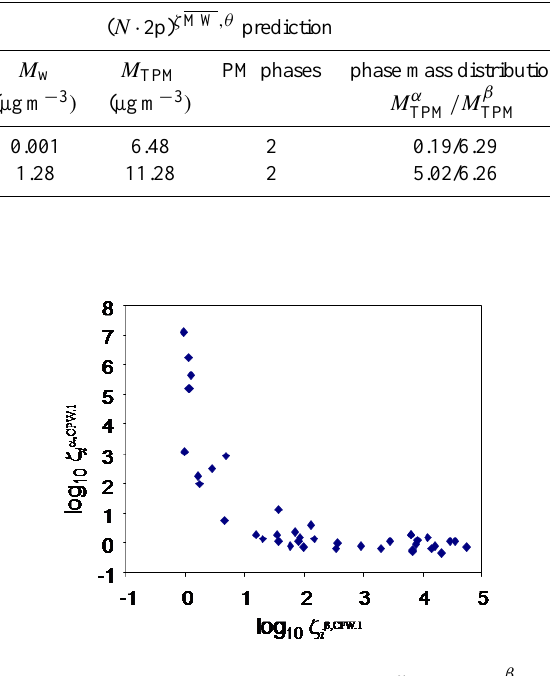
vs. log 10 ζ β as cal- i i